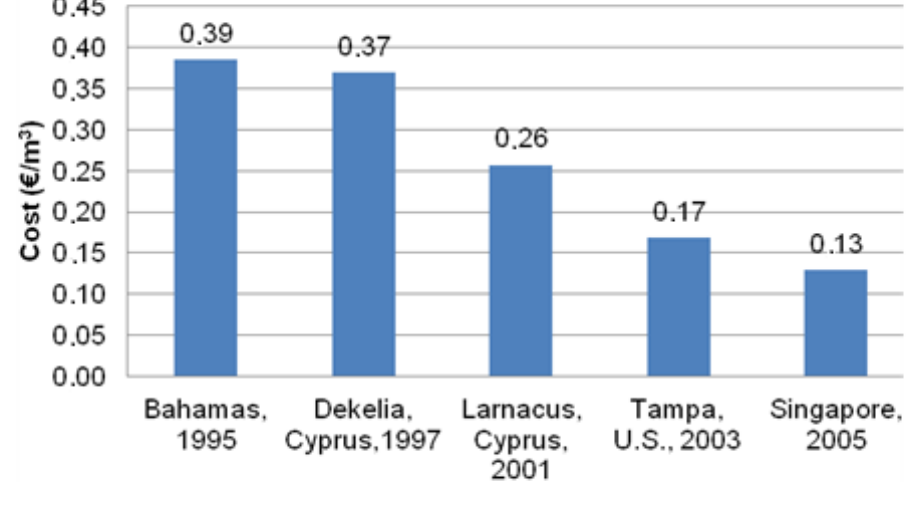
Figure 3. Cost of desalination plants that were installed between 1995 and